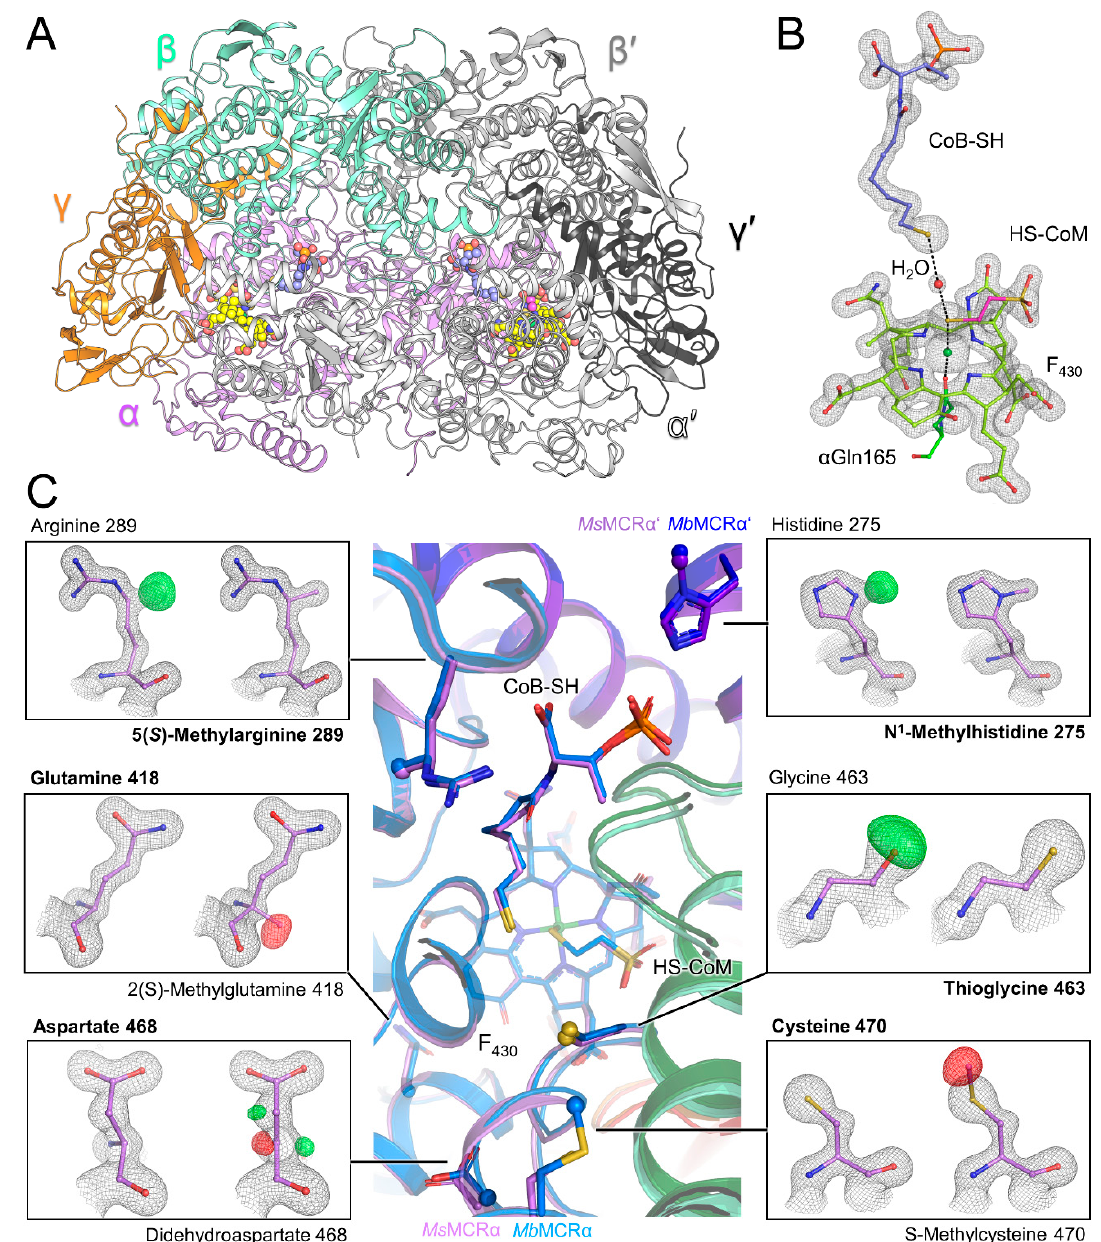
Figure 2. Ms MCR structure and its post-translational modifications. ( A ) Ms MCR ( αβγ ) 2 organization with each chain colored differently. F 430 , HS-CoM and CoB-SH are in balls and sticks and colored in yellow, pink, and light blue, respectively. ( B ) Close up of the active site. 2 F o - F c electron density map for the F 430 and coenzymes is contoured at 2- σ . ( C ) Superposition of Ms MCR (same color code as panel A) on Mb MCR ( α , β , γ in blue, dark green and red respectively). The ligands and modified residues are in balls and sticks with the modifications as spheres. Each panel presents the 2 F o - F c map contoured at 2- σ (black mesh) and the F o - F c map contoured at 4- σ (green, positive, and red, negative) after refinement for a classic (left) or modified (right) residue. Final modelled residue is highlighted in bold.